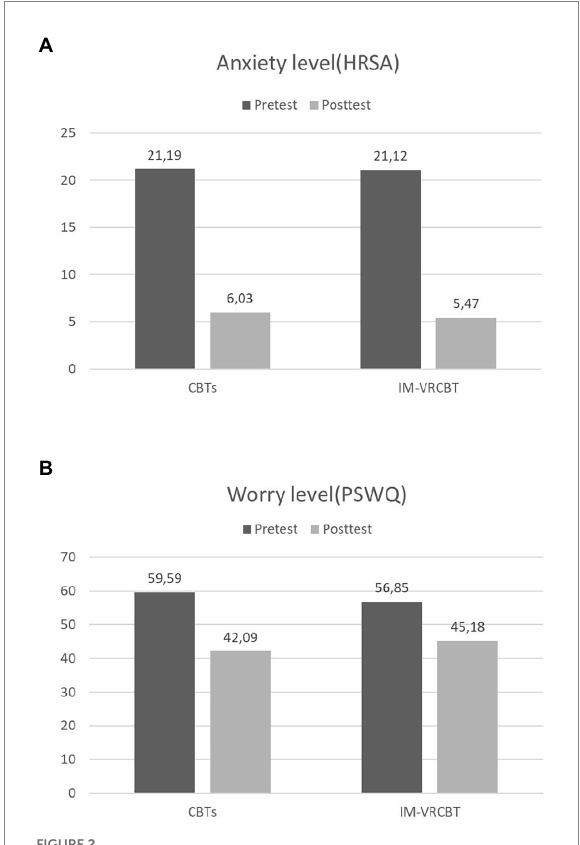
FIGURE 2 Differences in anxiety level, as measured with the Hamilton Rating Scale for Anxiety (A) and worry level, as measured with the Penn-State Worry Questionnaire (B) , between the CBTs and the IM-VRCBT groups from pre- to